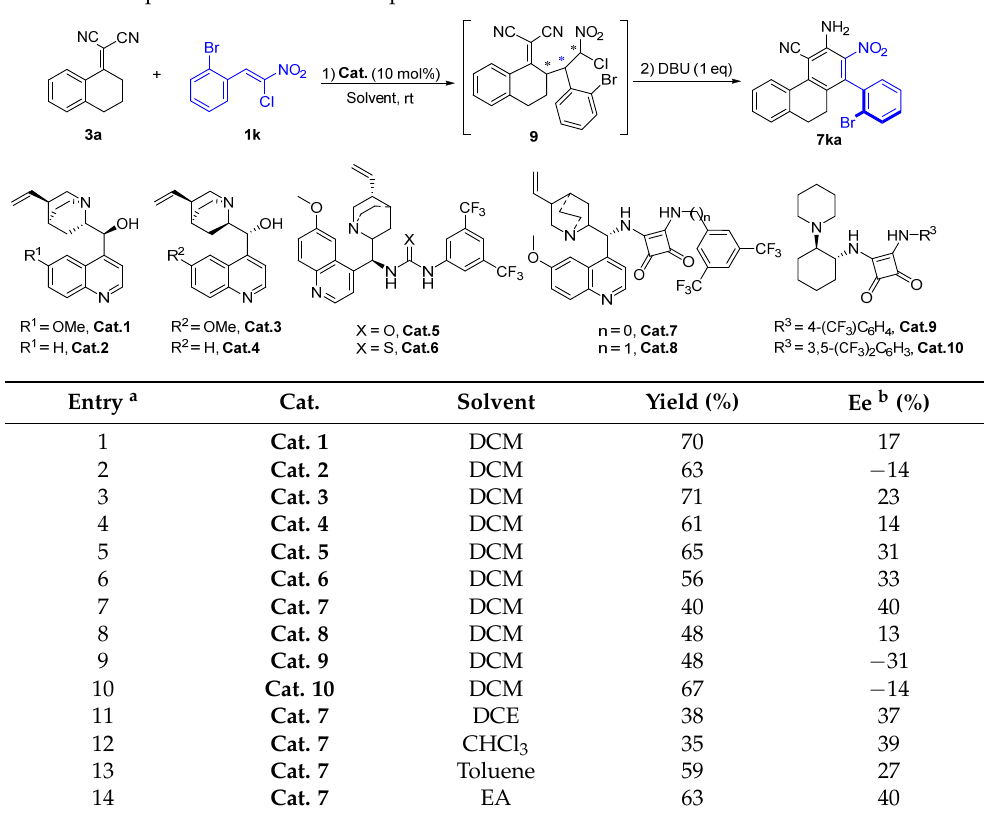
Table 2. The optimization of the chiral product.